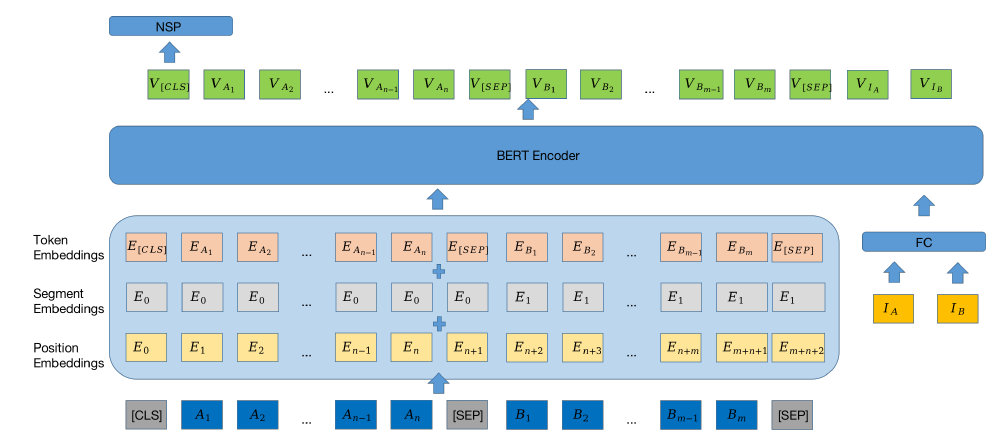
Figure 4. The framework of multimodal NSP pre-training and MEL fine-tuning. Text formats for input in the pre-training and fine-tuning phases are